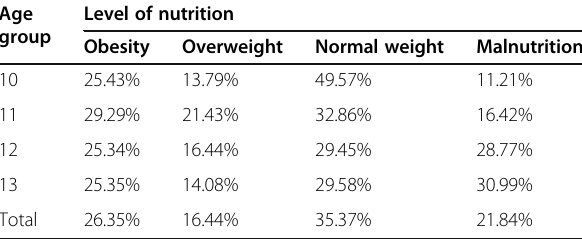
Table 2 Nutritional status of children in a given age group